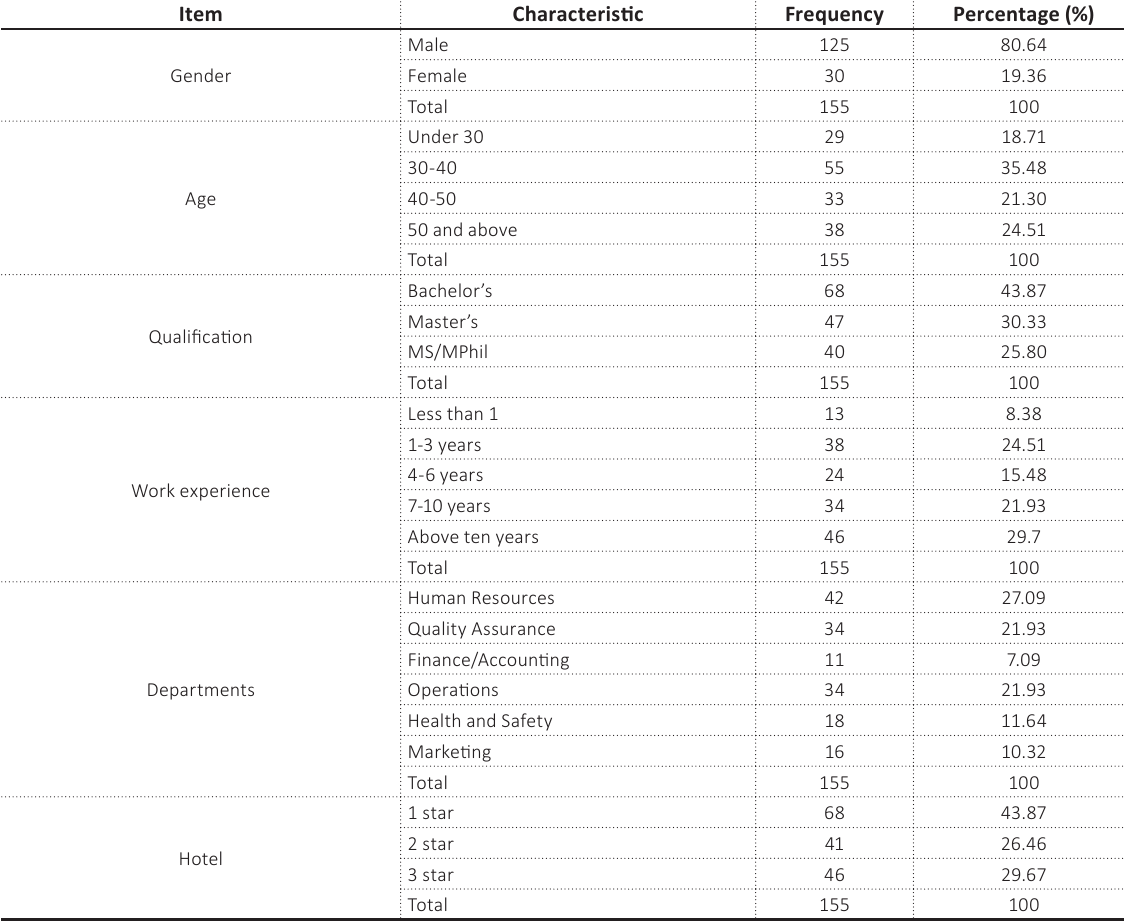
Table 1. Demographic